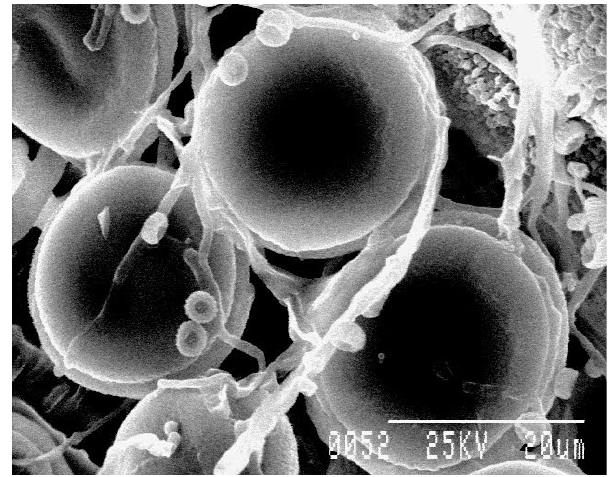
Fig. 9. X3000, showing spheroidal pollens of Nymphaea pubes- cens